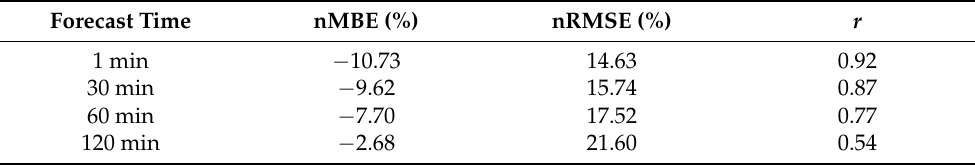
Table 3. Statistical errors of DNI forecasting on the ground for the two cloudless days selected. Forecast Time